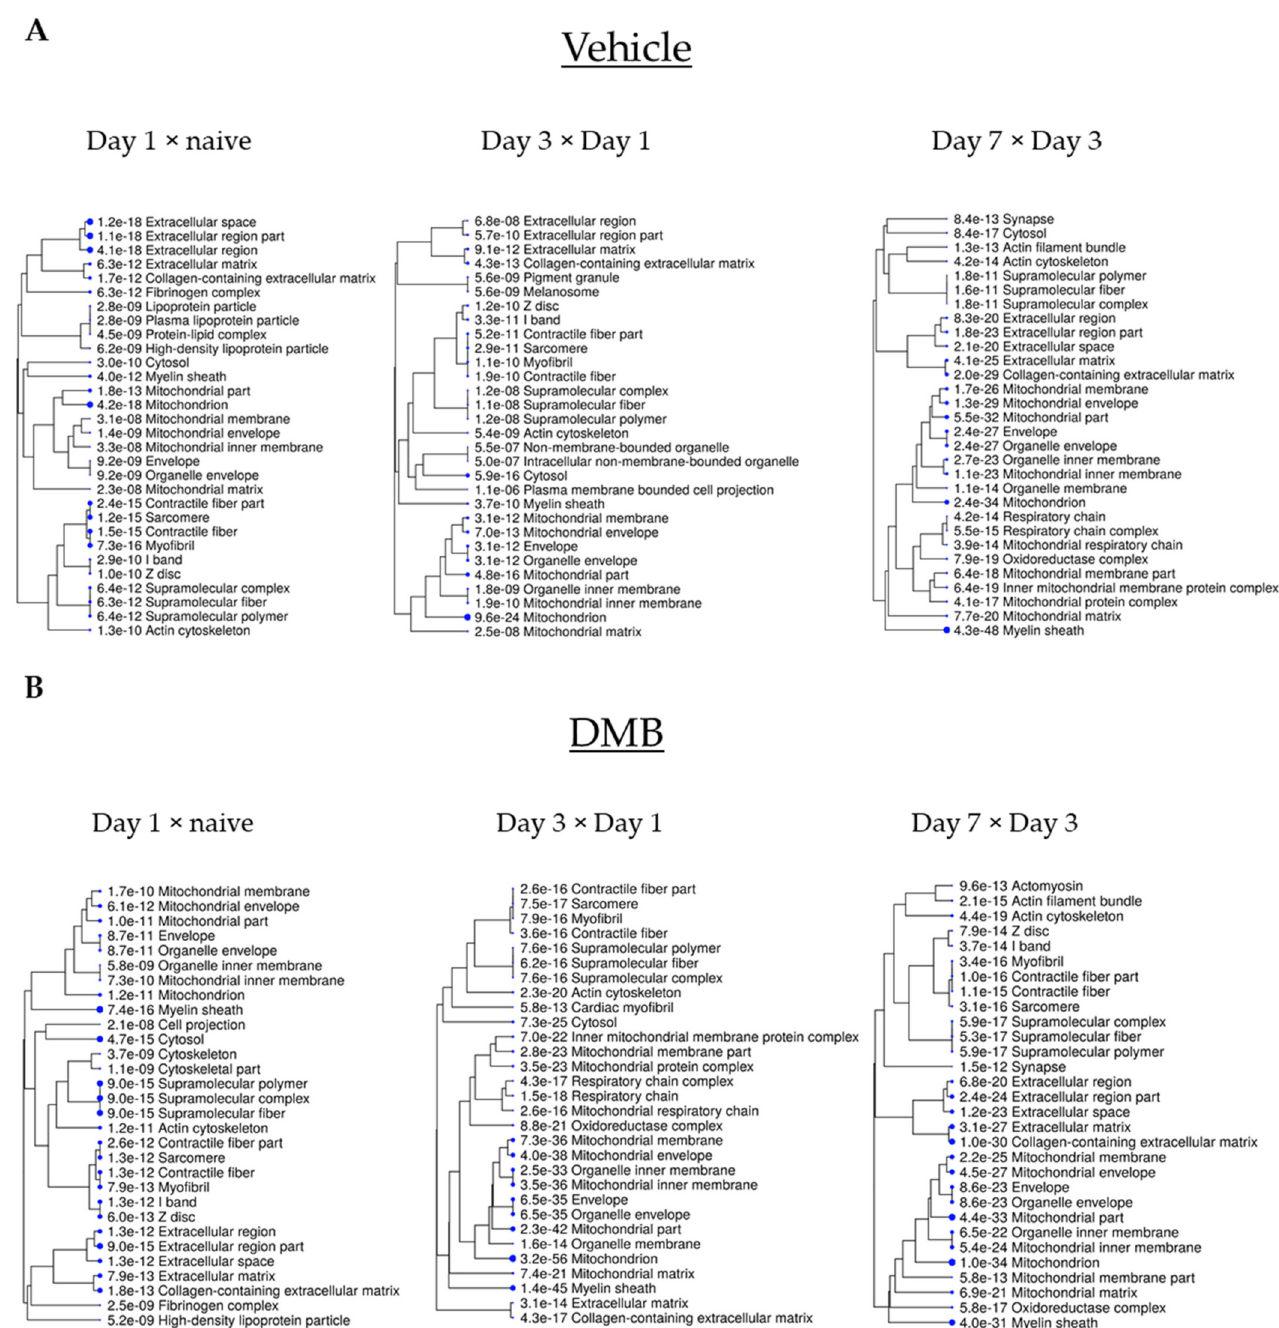
Figure 2. Top 30 cellular components of the unique proteins and DEPs in the intragroup comparison. The expression of proteins from each time point was compared to its preceding time point intragroup to identify unique proteins and DEPs ( p < 0.05). A list containing all unique proteins and DEPs at each time point was uploaded on ShinyGO v0.61 and cellular components were obtained. Cellular components were clustered according to the amount of proteins they have in common, and the size of the blue dots represent p -values (the bigger the size, the lower the p -value). ( A ) Cellular components of unique proteins and DEPs in the vehicle-treated group; ( B ) cellular component of unique proteins and DEPs in the DMB-treated